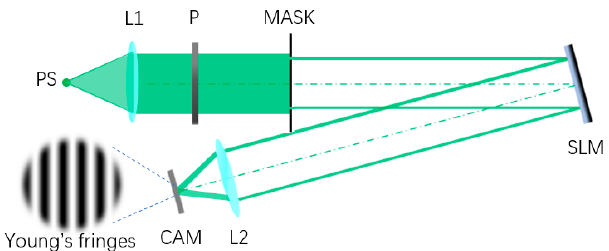
Figure 3. Configuration of the self-referenced phase calibration method for reflective LCoS (HOLOEYE GAEA-2). PS: monochromatic point light source; L1: collimating lens; P: polarizer; MASK: mask with two small holes; L2: Fourier lens; SLM: spatial light modulator; CAM: camera.